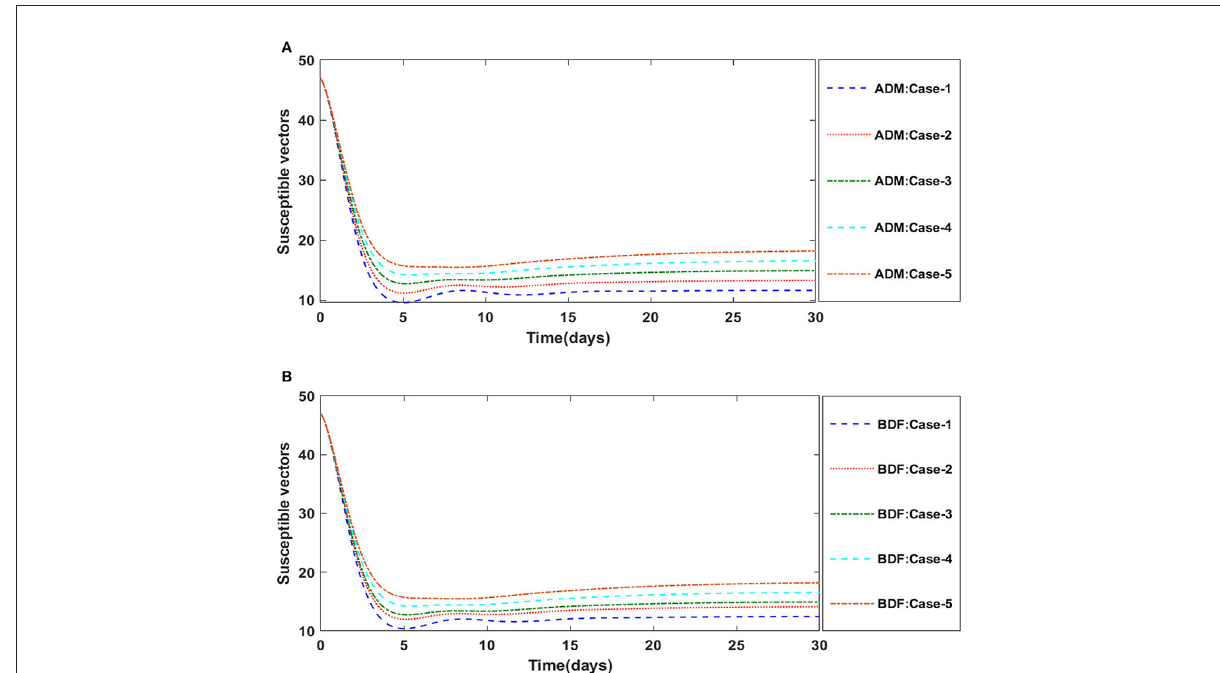
FIGURE8 (A) Dynamics of infected plants for the varition in υ using ADM for model A1. (B) Dynamics of infected plants for the varition in υ using BDF for model A1.